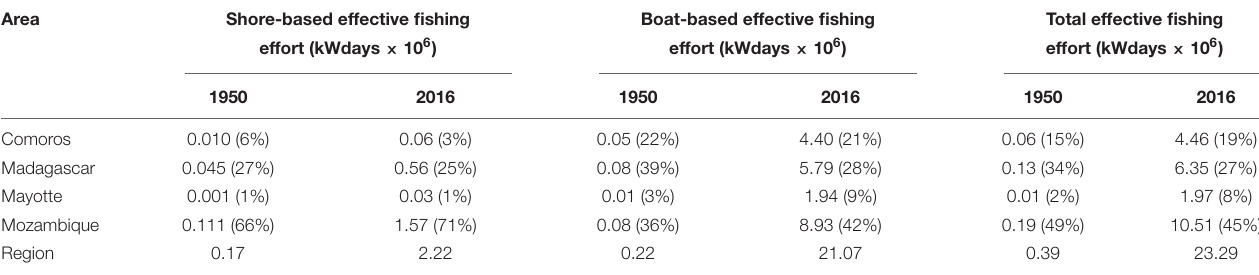
Area Shore-based effective